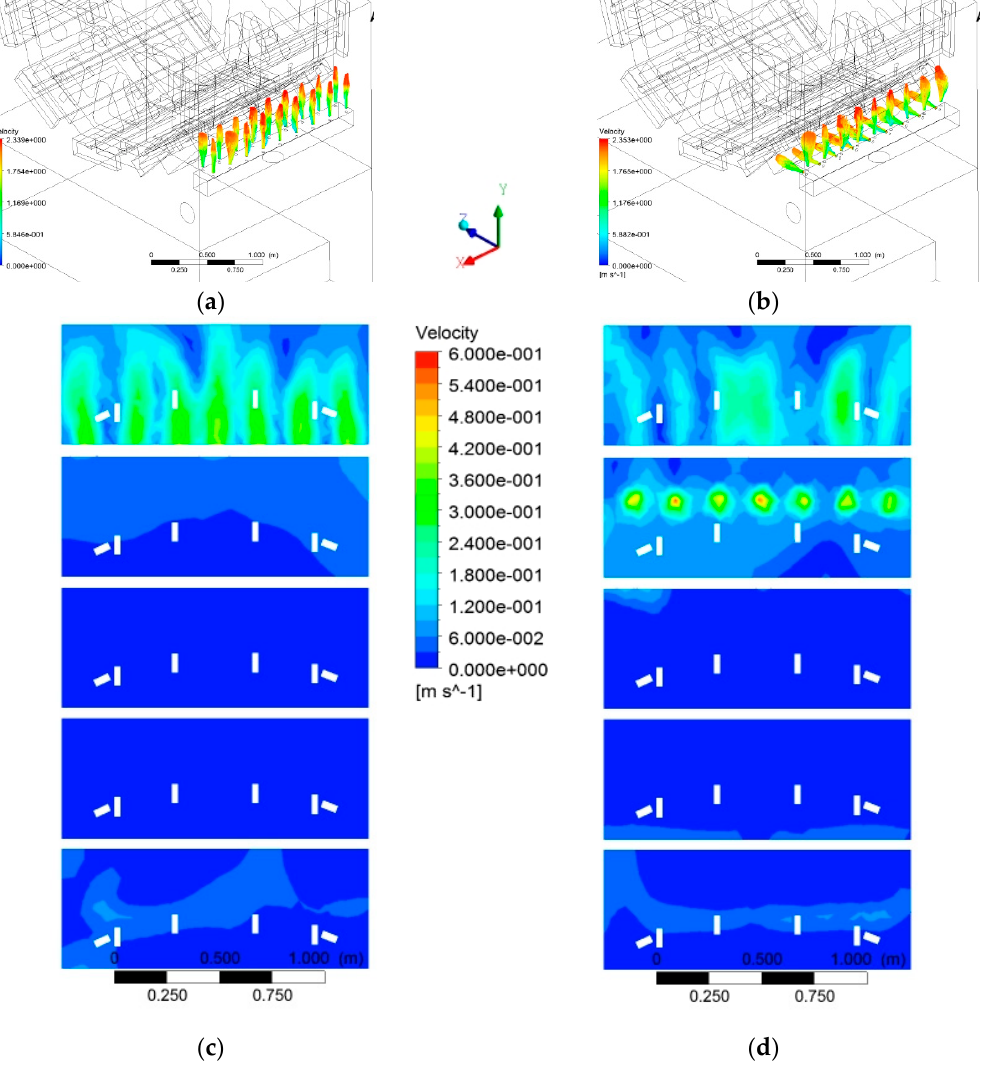
Figure 16. Computed oil velocity distribution at nozzle exit for: ( a ) Original case, ( b ) nozzle rows at 90° between them. Computed velocity maps at frontal face areas of virtual boxes for ( c ) Original case, ( d ) nozzle rows at 90°.